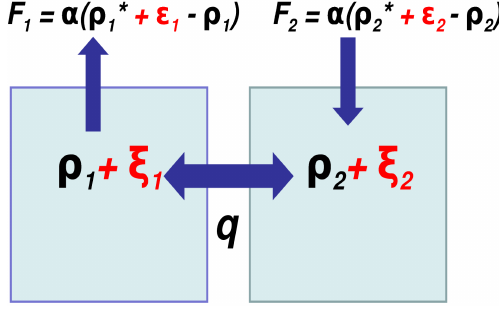
Fig. 3. Conceptual box model used to illustrate how to extract the chaotic MOC component from the NEMO experiments. See main text for